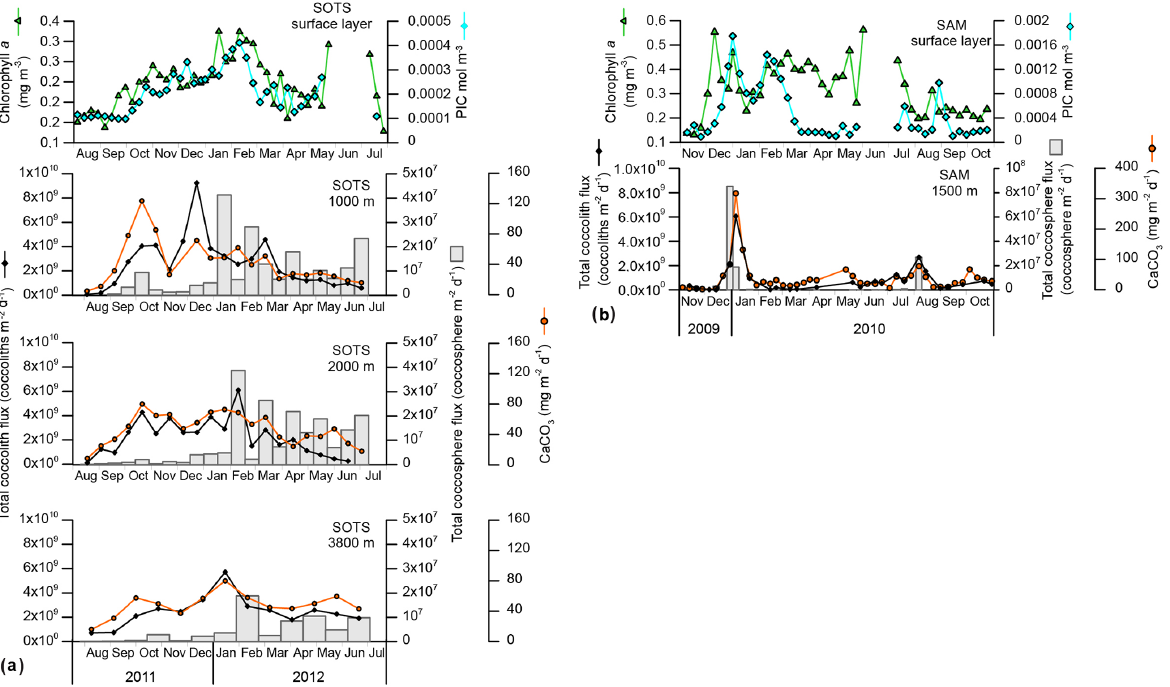
Figure 2. Ocean-colour satellite-derived chlorophyll a and particulate inorganic carbon (PIC) concentration in the surface layer and total CaCO 3 , coccolith and coccosphere fluxes registered by the sediment traps at the SOTS (a) and SAM (b)